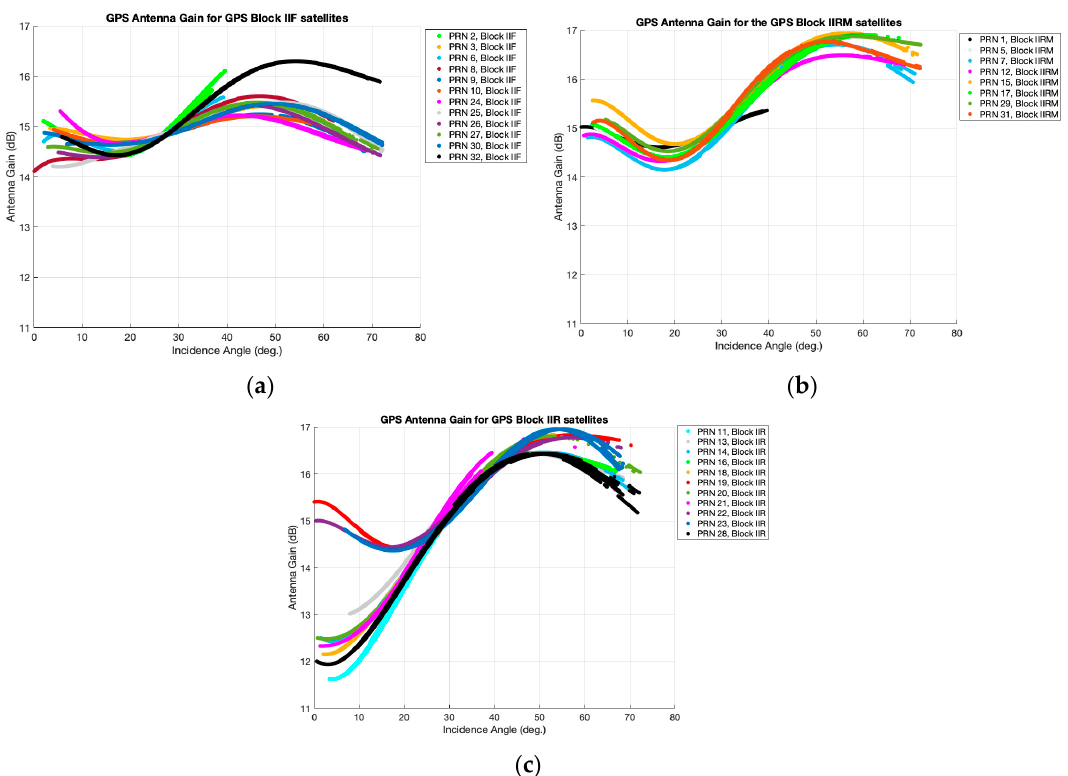
Figure 6. GPS antenna gain G tx for the 32 satellites of the constellation. The information is in the variation range of those transmitted power. Each color corresponds to a different GPS satellite. Each color corresponds to a different GPS satellite. ( a ) GPS block IIF satellites are represented by circles, ( b ) GPS block IIRM satellites are represented by squares, and ( c ) GPS block IIR are represented by crosses.